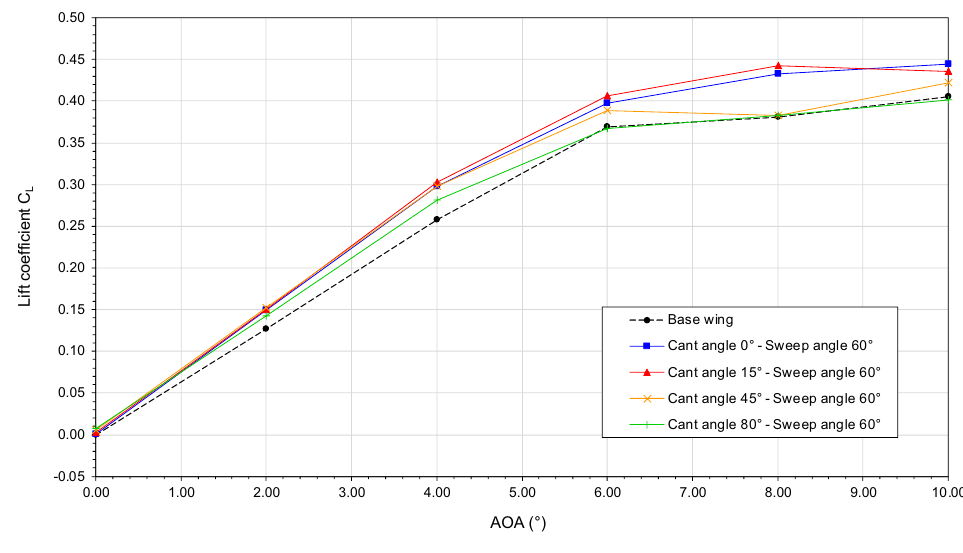
Figure 16. Lift coefficient versus angle-of-attack at Mach number 0.8395, winglet sweep angle 60 ◦ and different values of cant